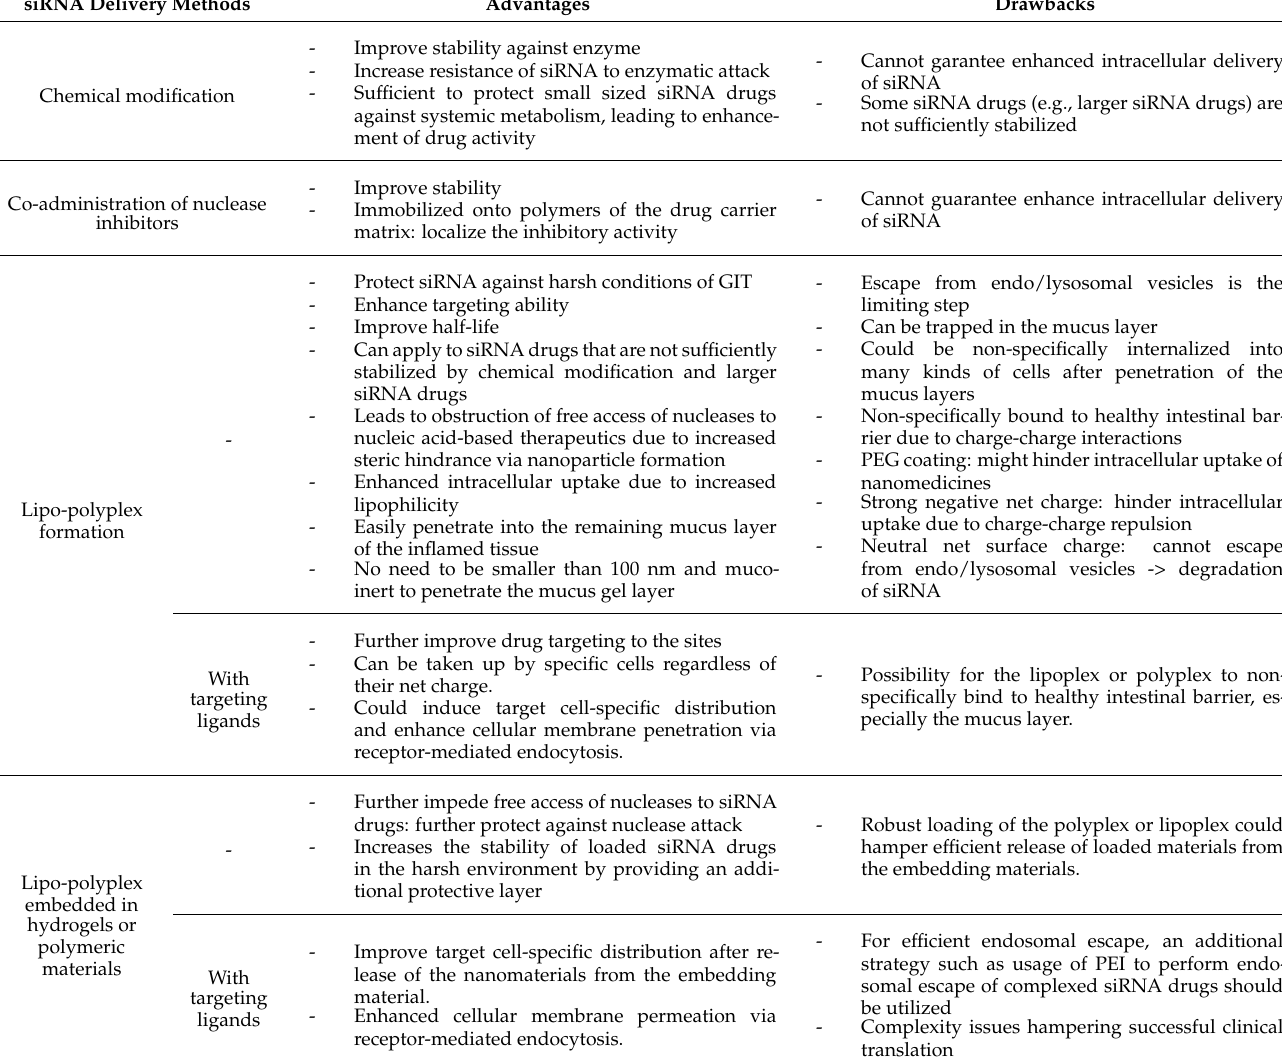
Table 1. Strategies for the oral delivery of siRNA